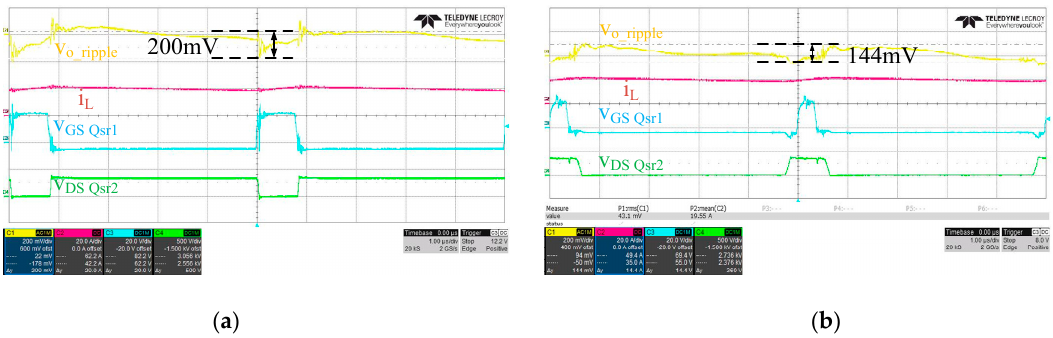
Figure 21. Switching noise performance: output voltage ripple, output inductor current waveform, Q sr 1 switch’s v GS signal and Q sr 2 switch’s v DS voltage at V O = 50 V, Io = 20 A ( a ) without peration of auxiliary circuit ( b ) with peration of auxiliary circuit (scale v o ripple (Ch1): 200 mV/div; i L (Ch2): 20 A/div; v GS_Qsr 1 (Ch3): 20 V/div; v DS_Qsr 2 (Ch4): 500 V/div; time: 1 μ s/div).